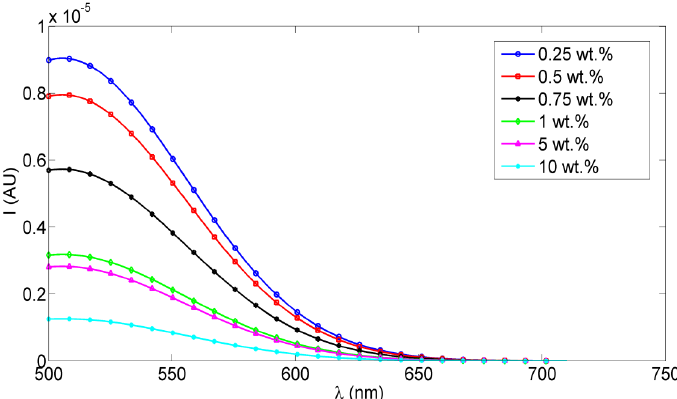
Figure 2. Fluorescence intensity PVA NFs with in situ embedded different concentrations of ceria NPs.